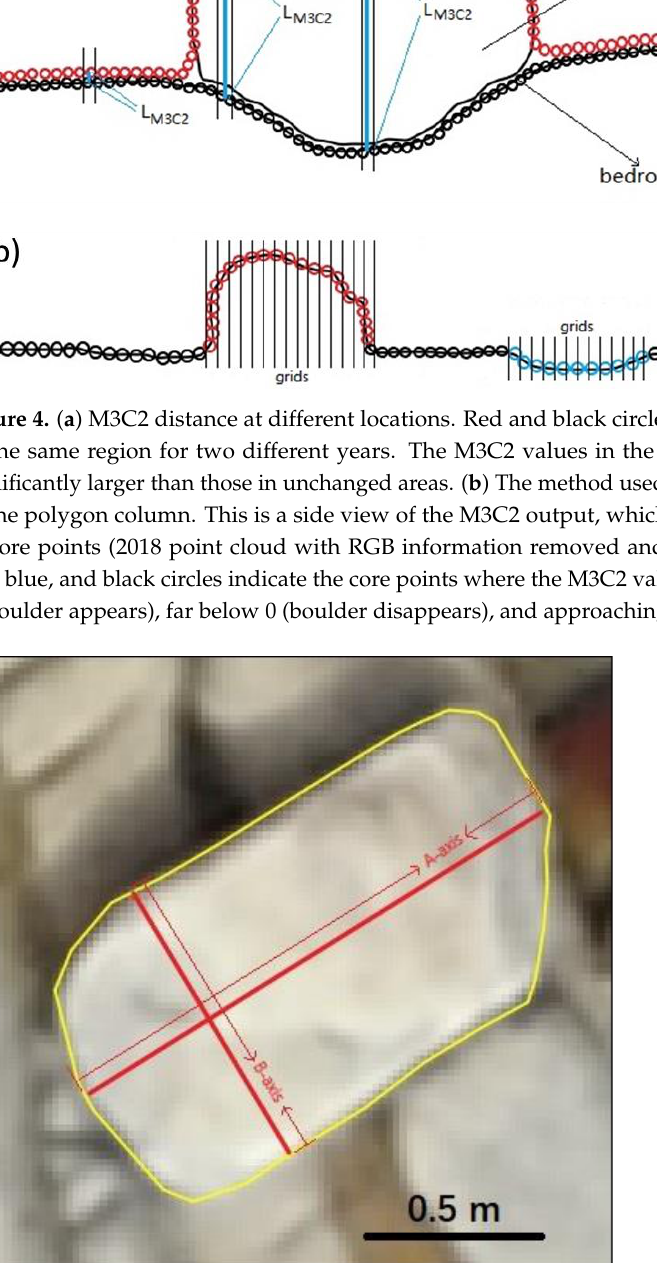
Figure 5. Measuring the length of the a-axis and b-axis in orthomosaics.